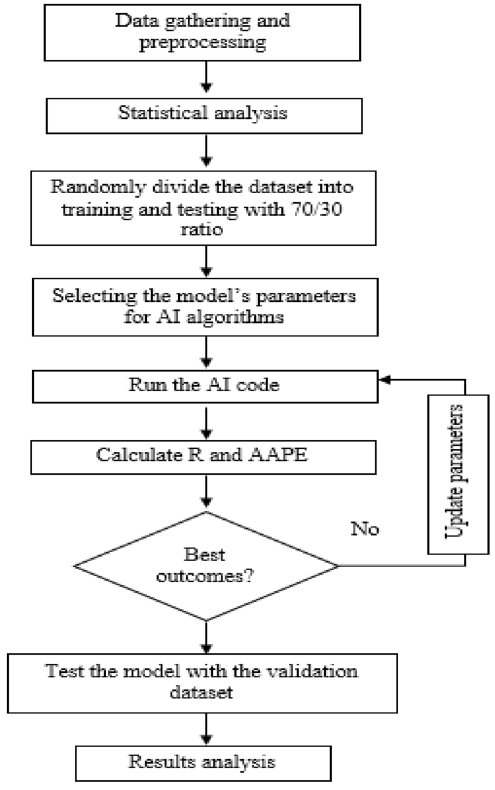
Figure 1. Flow chart for the methodology used to generate